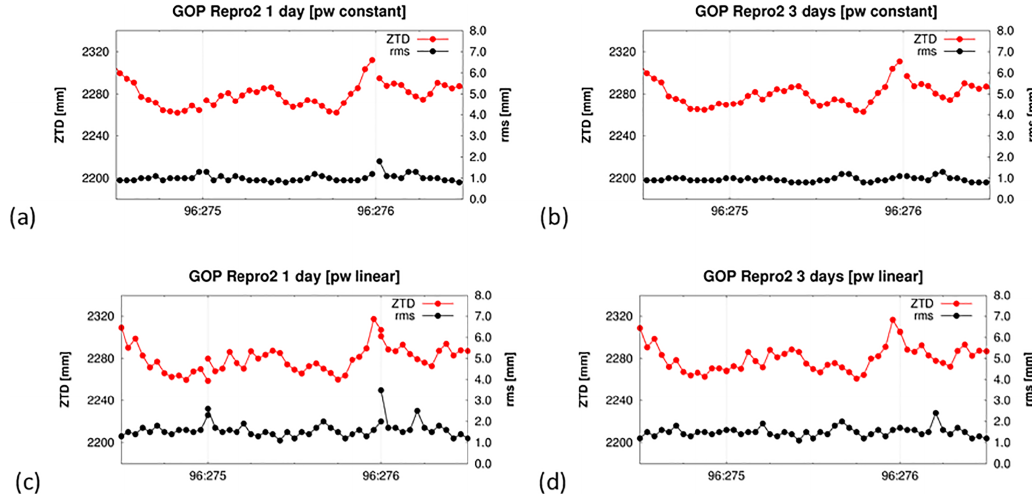
Figure 3. Four variants of representation of tropospheric parameters. Right (b, d) and left (a, c) panels display estimates with and without midnight combinations, respectively. Top (a, b) and bottom (c, d) panels display the piecewise constant and the piecewise linear model, respectively.